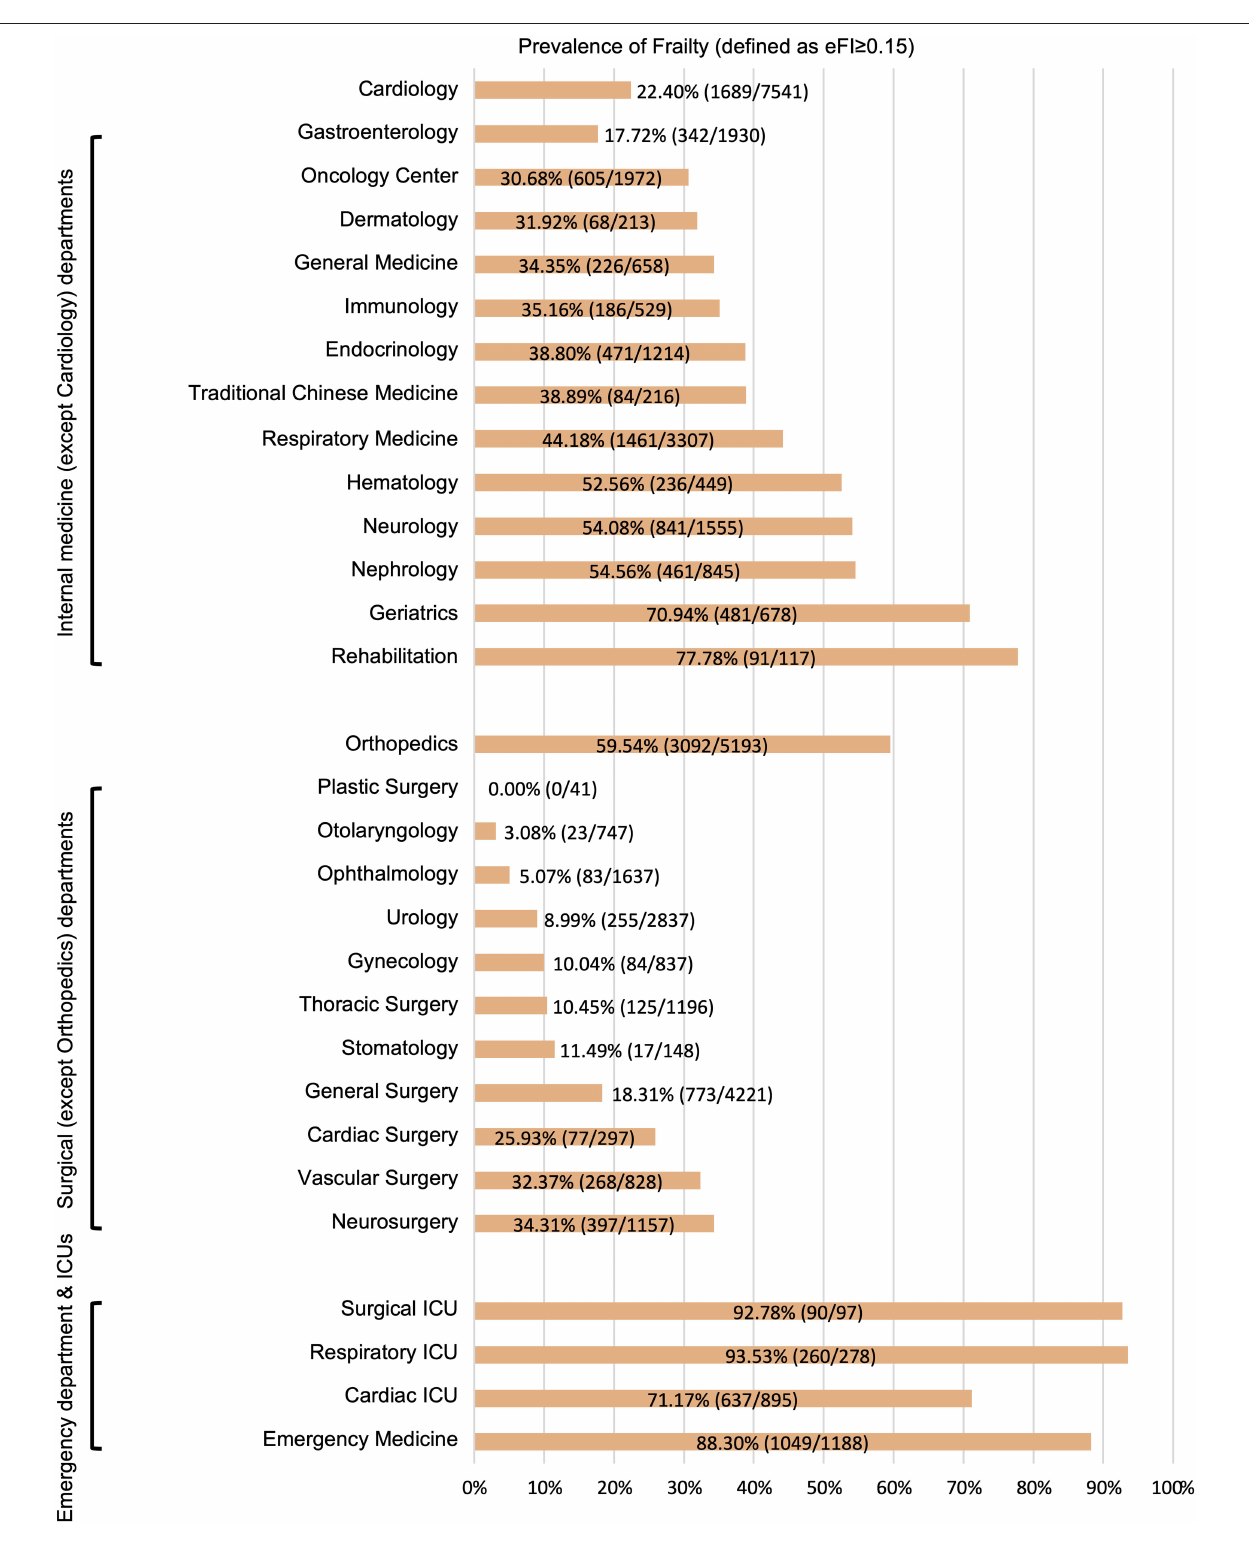
FIGURE 2 | Prevalence of frailty in different departments. eFI, electronic frailty index; ICUs, intensive care units.